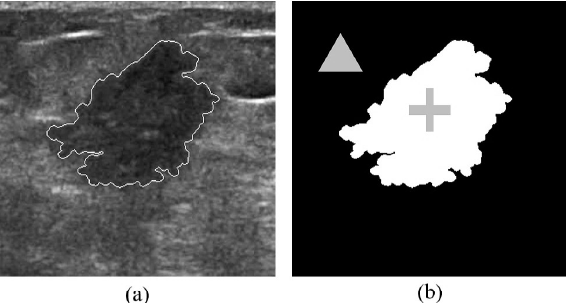
Figure 11. Illustration of CNN on an input image: ( a ) original image with a size of 321 × 321; ( b ) sample image cropped on the original image—size was reduced to 99 × 99. The cross-shaped is a positive sample (tumor), but the triangular one is a negative sample (background).